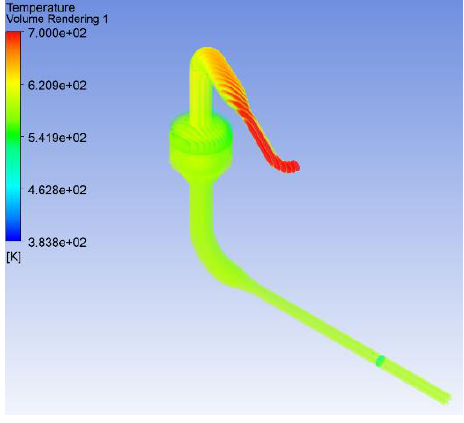
Fig. 16. Temperature distribution within the exhaust